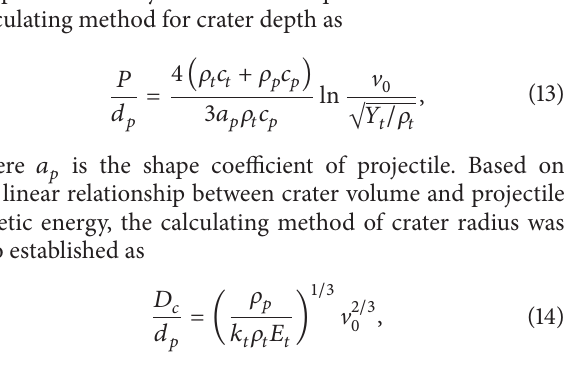
Figure 5: Dimensionless penetration depth versus projectile impact